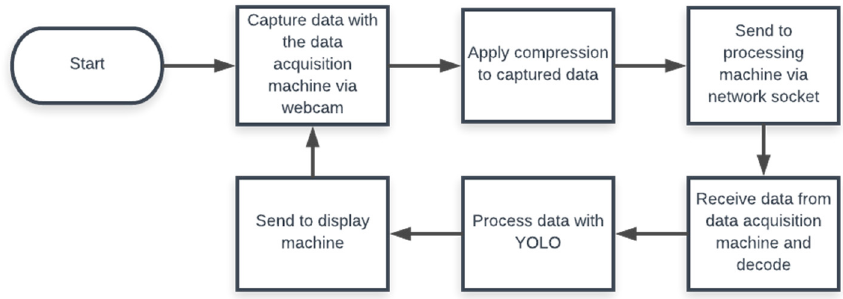
Figure 6. Flowchart 2: processing modules.